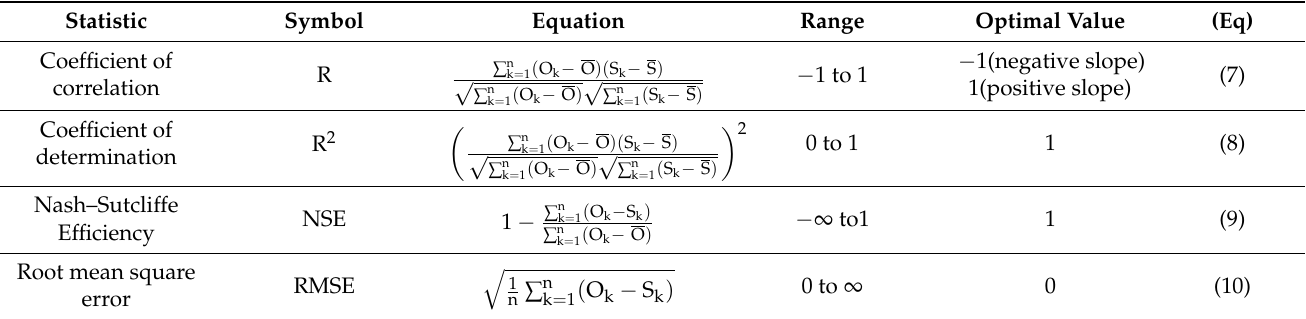
Table 2. Model performance statistics, their equations, ranges, and optimal values, modified from [42]. O and S are observed and simulated values for a time series with length n and O and S are the mean values,